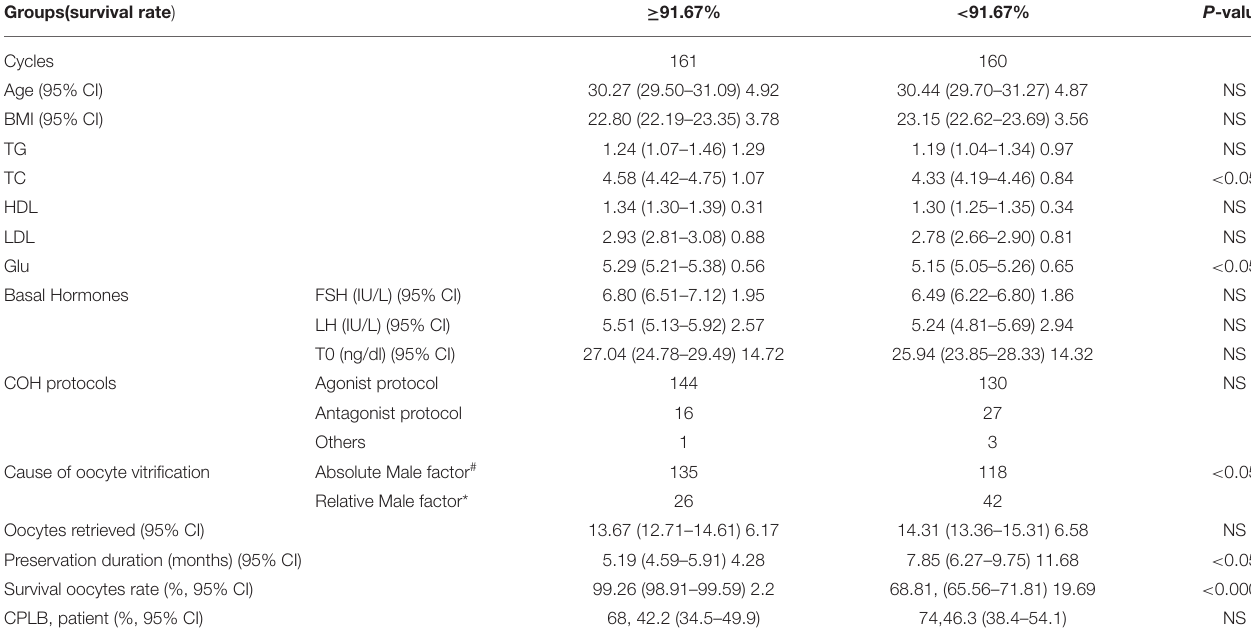
TABLE 3 | Patient and cycle characteristics and CPLB in the two oocyte vitrification groups divided by the median survival rate (91.67%). Groups(survival rate )